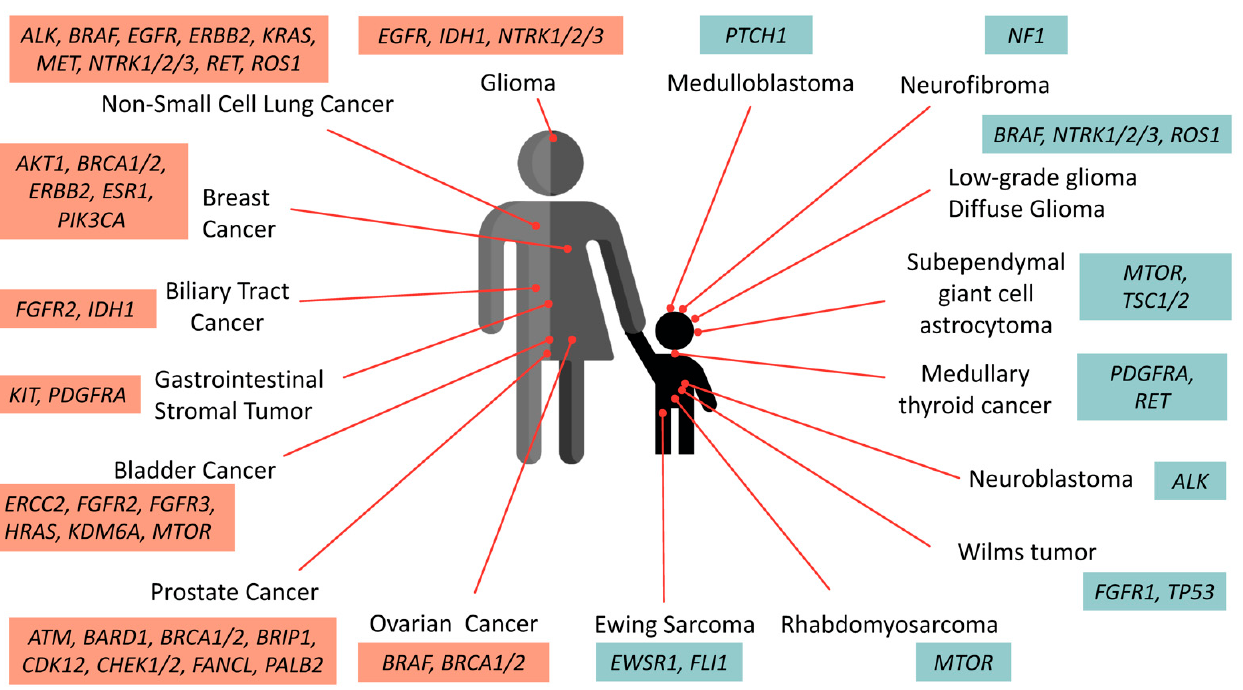
Figure 1. Oncogenic drivers identified in adult and pediatric solid tumors. These selective biomarkers are predicted to be responsive to various levels of FDA-approved drugs (detailed in Table 1). Note that targeted therapies against PTCH1 and ALK in medulloblastoma and neuroblastoma are currently undergoing clinical assessment and awaiting further approval. Table 2. Targeted therapies recommended for the selected genetic alterations according to FDA- approved or NCCN guidelines [60].